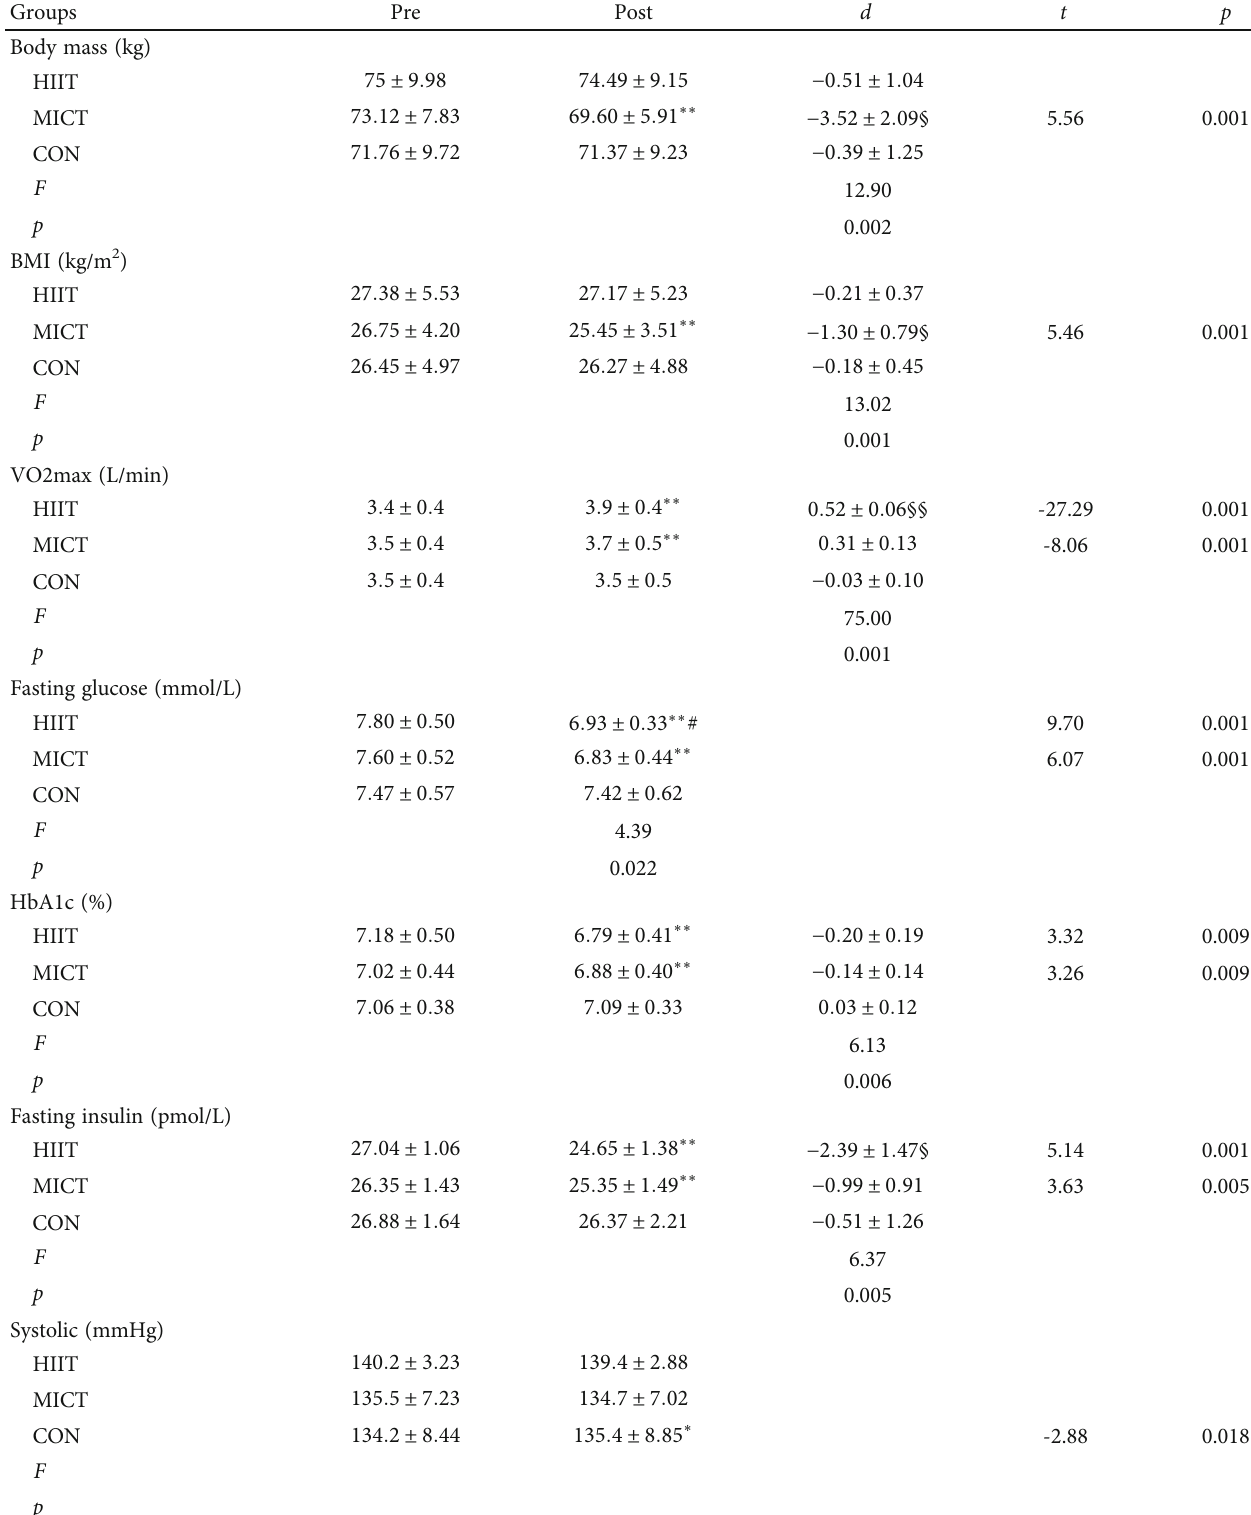
Table 2: Changes in participants ’ characteristic body composition, VO2max peak, blood glucose, and blood pressure control. Groups Pre Post d t p Body mass